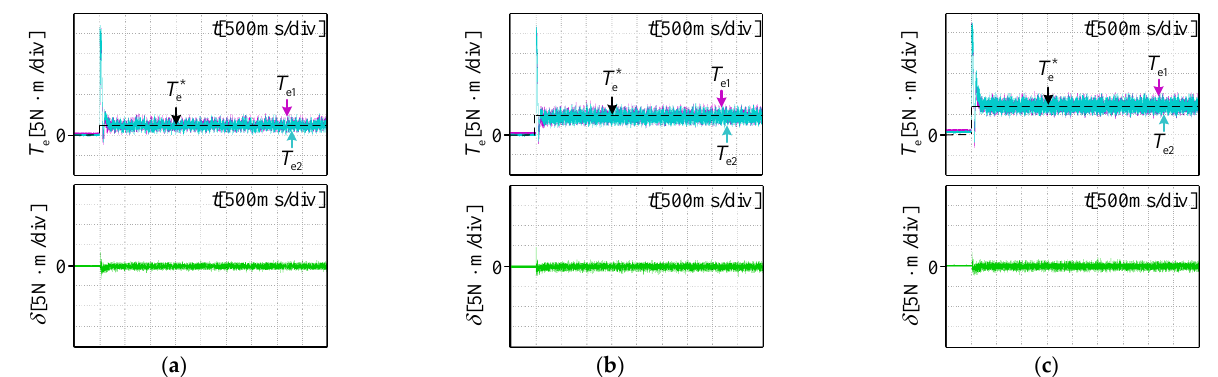
Figure 14. Steady-state waveforms of the proposed FCS-MPC strategy: ( a ) load torque is 5 N · m, ( b ) load torque is 10 N · m and ( c ) load torque is 15 N · m.